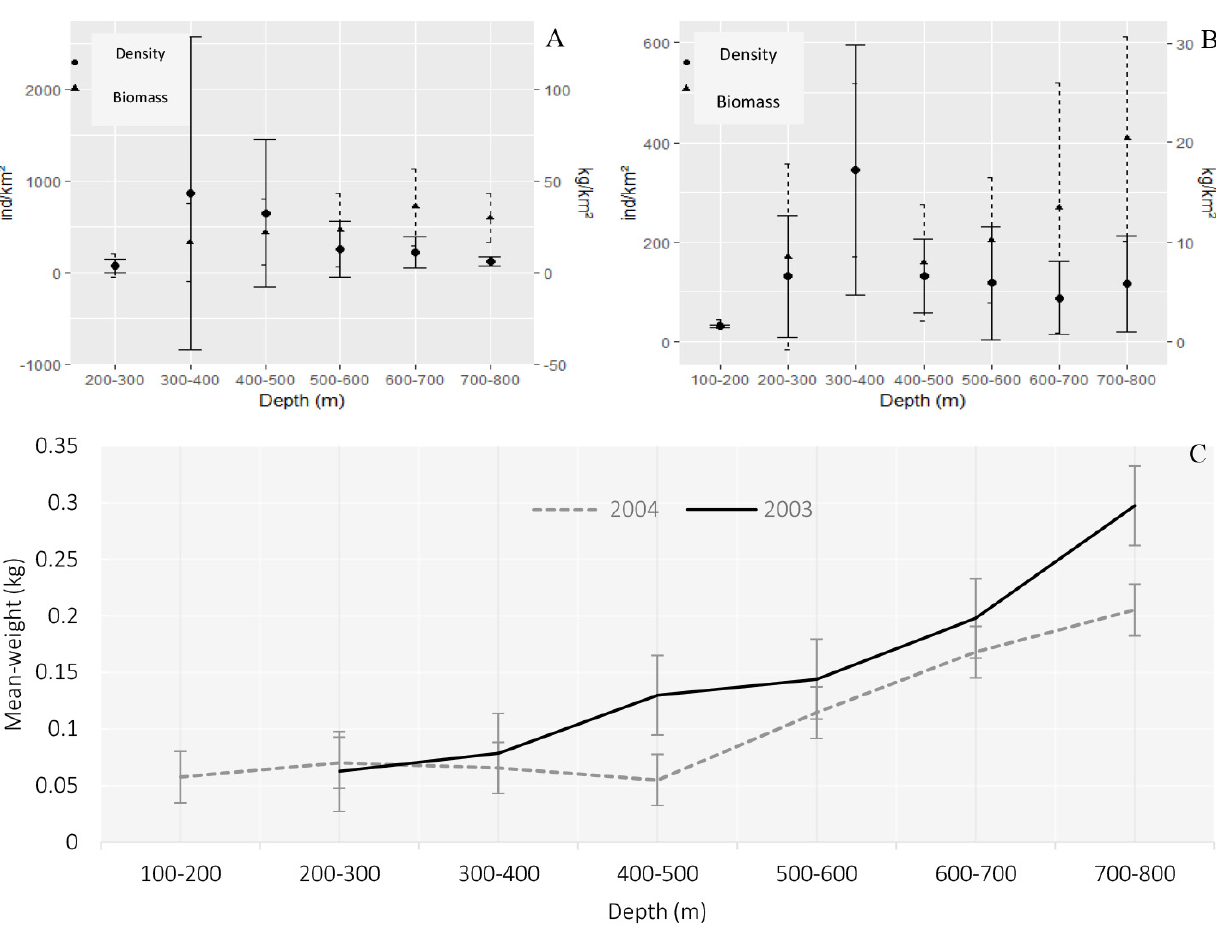
Fig. 2. Density (ind/km 2 ), biomass (kg/km 2 ) of P. blennoides with depth stratum (m) caught by the bottom trawl surveys in 2003 (A) and 2004 (B) along the Algerian coast and mean weight (kg)